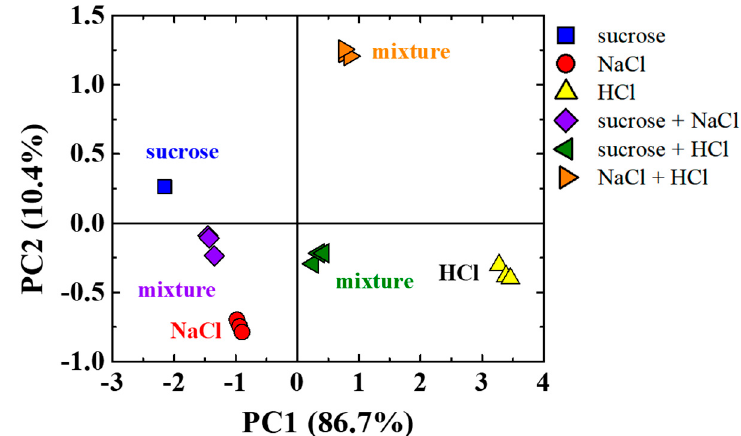
Figure 6. PCA score plots of the capacitance data at 1 kHz in three independent sets of measurements obtained using a microfluidic e-tongue to evaluate sucrose, NaCl, HCl, and their mixtures obtained under flow (1 mL / h) inside a Y-shaped PDMS microchannel with a passive mixer.